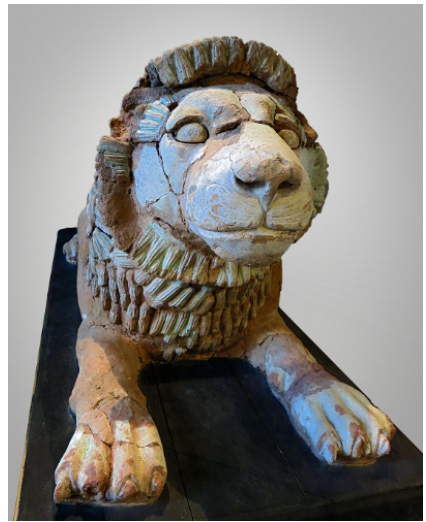
Figure 19. Recumbent guardian lion (Louvre inv. no. Sb 2716); glazed terracotta sculpture; Susa (Acropolis), Elam (mod. Iran); Elamite, 14th–12th cent. BCE [photography by Karl Steel; CC BY-NC-SA 2.0 License].